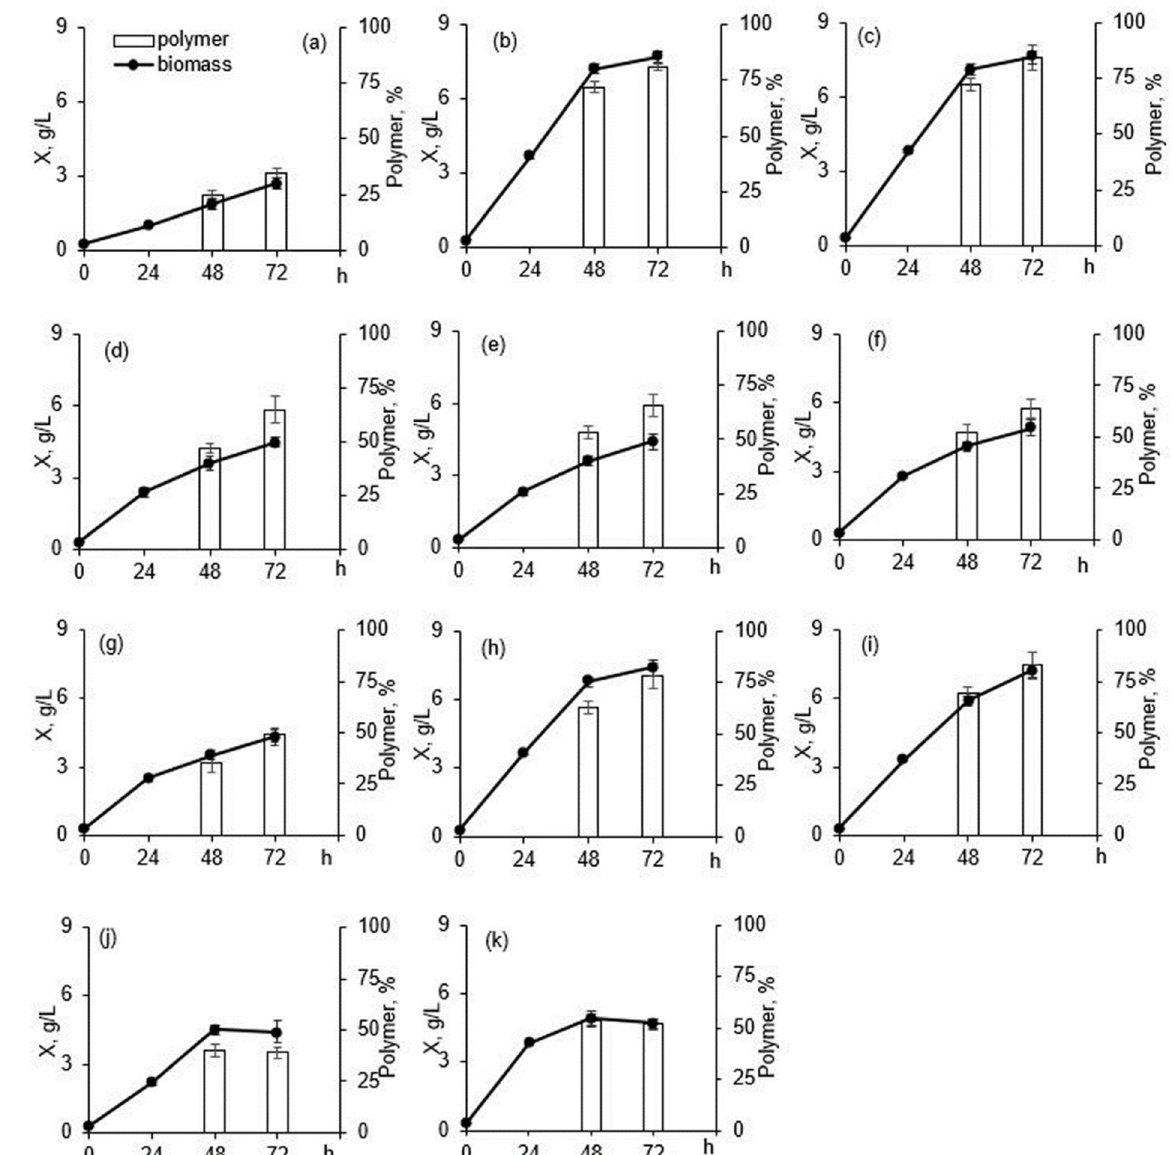
Figure 2. Cell dry weight and PHA production by Cupriavidus necator IBP/SFU-1 grown on different substrates. ( a ) CO 2 , ( b ) fructose, ( c ) glucose, ( d ) glycerol, ( e ) lauric acid, ( f ) myristic acid, ( g ) palmitic acid, ( h ) oleic acid, ( i ) palm oil, ( j ) sunflower seed oil, ( k ) Siberian oilseed oil.